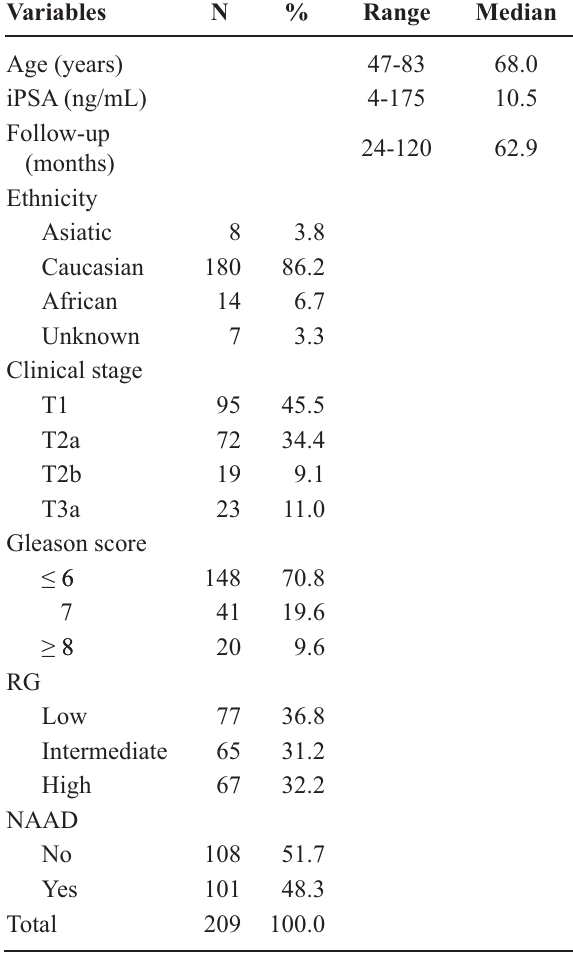
Table 1 – Patients